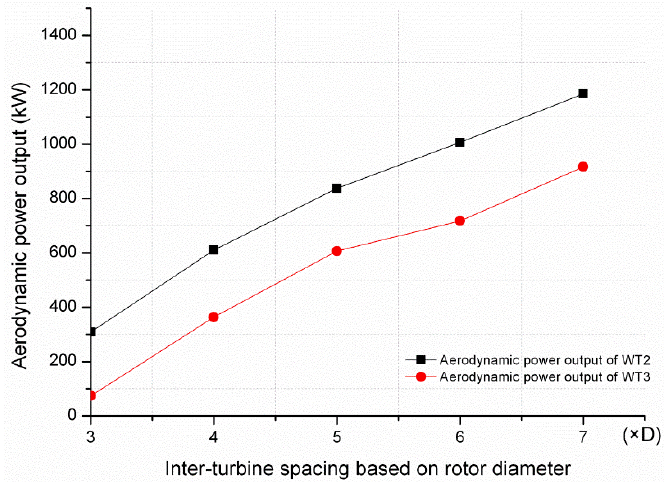
Figure 5. Aerodynamic power output of wind turbine WT2 and WT3 according to inter-turbine distance